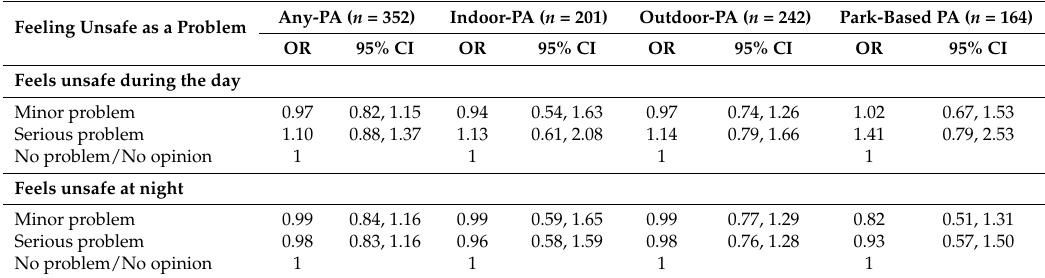
Table 6. Adjusted odds ratios between perceived safety and physical activity (PA) a